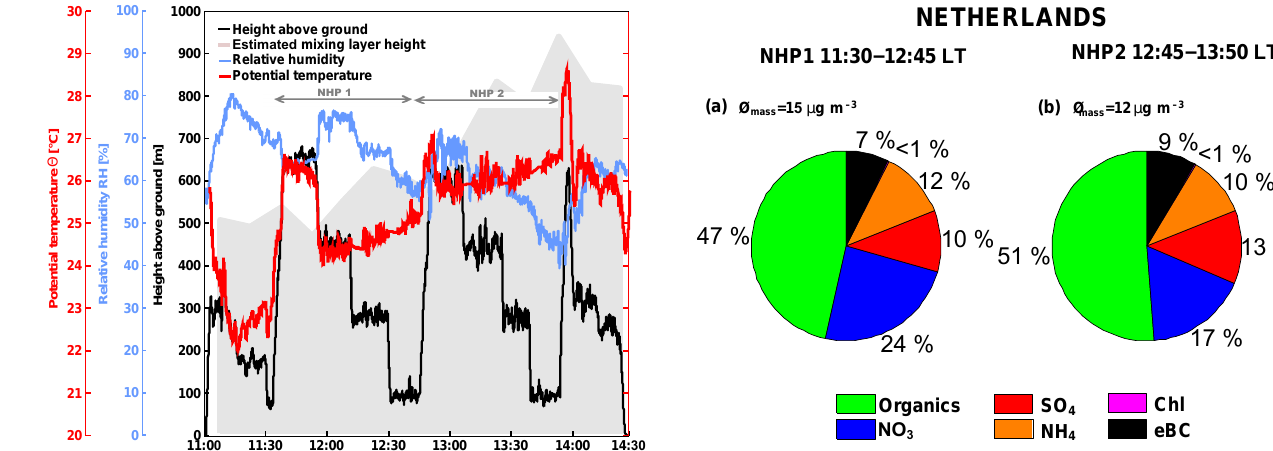
Figure 9. Overview of the flight on 24 May 2012 near the Cabauw CESAR station in the Netherlands. In black the flight altitude and in grey the estimated mixing layer height, inferred from ceilometer measurements, are presented. The red and blue lines show the po- tential temperature (cid:50) and RH profiles, respectively. In addition, the different height profiles NHP1 and NHP2 are indicated.